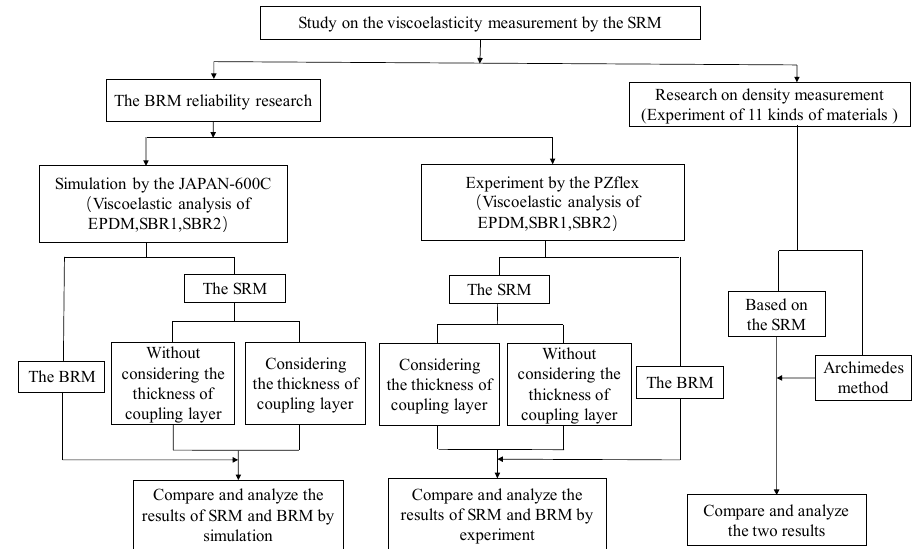
Figure 4. The flowchart of the process adopted for research on viscoelasticity. EPDM = ethylene propylene diene monomer; SBR = styrene butadiene rubber.